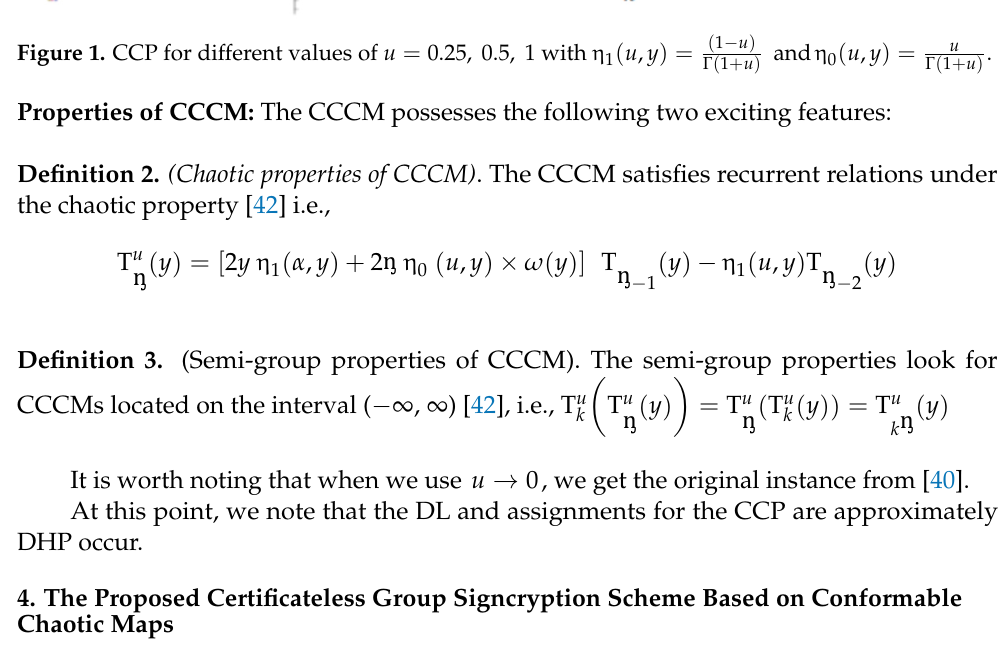
Figure 1. CCP for different values of u = 0.25, 0.5, 1 with η 1 ( u , y ) = ( 1 − u ) Γ